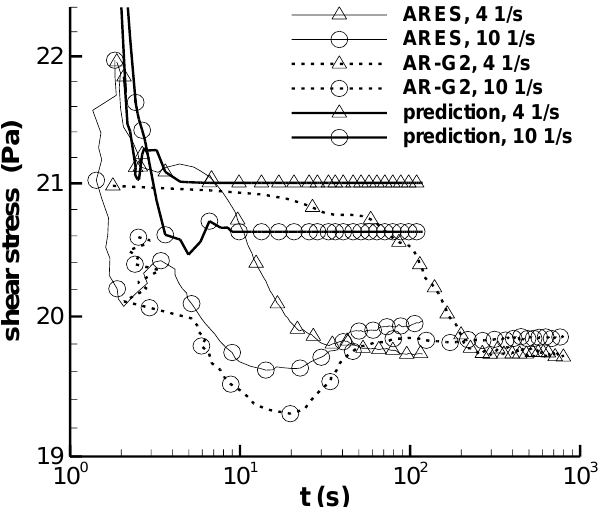
Figure 3. Prediction of the stress growth at 70 s −1 . The symbol is the experiment in Figure 13 of Pipe et al. [3], and the line is the calculation here.